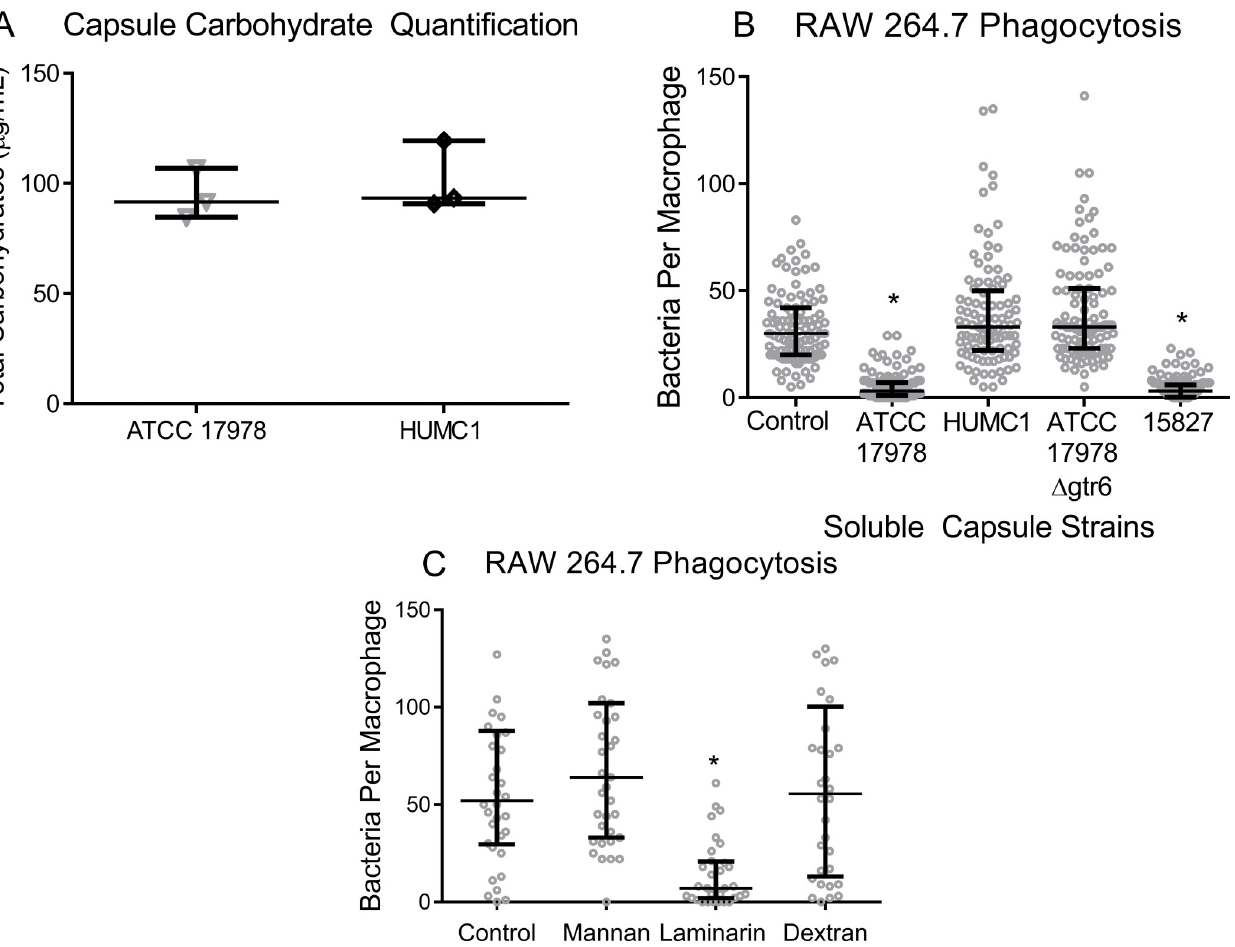
Fig 4. Quantification of capsule content, pre-incubation of phagocytes with purified bacterial capsule, and pre-incubation of phagocytes with soluble carbohydrates. ( 4A ) 2.0 × 10 8 CFU of ATCC 1778 and HUMC1 had total capsule carbohydrate capsule extracted in parallel and total carbohydrate content measured via phenol-sulfuric acid colorimetry. ( 4B ) Incubation of macrophages and bacteria with purified capsule from gtr6 + (ATCC 17978, 15827) and gtr6 - (HUMC1, ATCC 17978 Δ gtr6 ) strains. Extract-free uptake was used as a control. � p < 0.0001 (4C) RAW 264.7 cells were pre-incubated with soluble mannan (0.5mg/mL), laminarin (0.5mg/mL), and dextran sulfate (0.1mg/mL) or an untreated control prior to co-incubation with ATCC 17978. � p < 0.0001. Two biological replicates for in vitro . Wide bars denote median, error bars denote IQR.